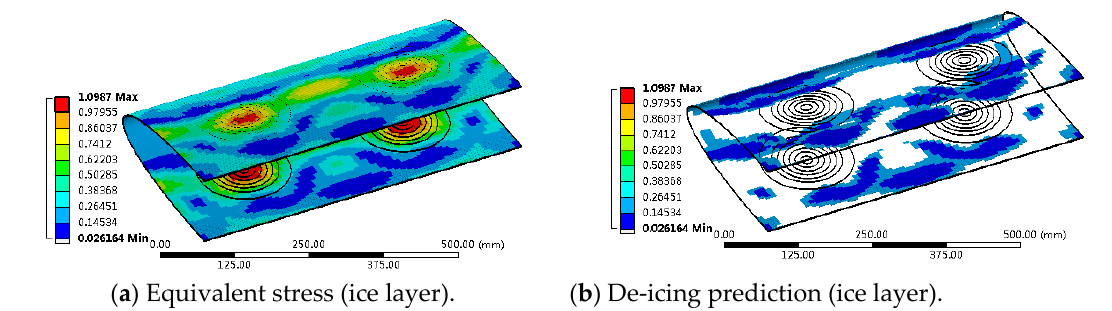
Figure 14. Electro-impulse de-icing system of four coils.